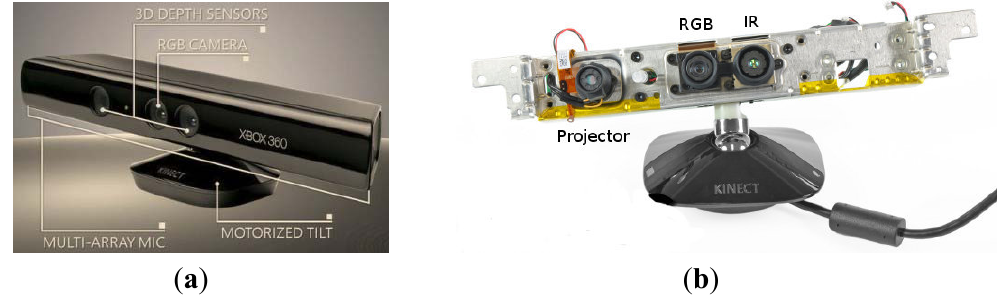
Figure 1. ( a ) A photo showing all the different parts of the sensor, external view of the 3D depth sensors, RGB camera, multi-array microphone, and a motorized tilt taken at Microsoft's E3 2010. ( b ) Internal view of the device from [40].